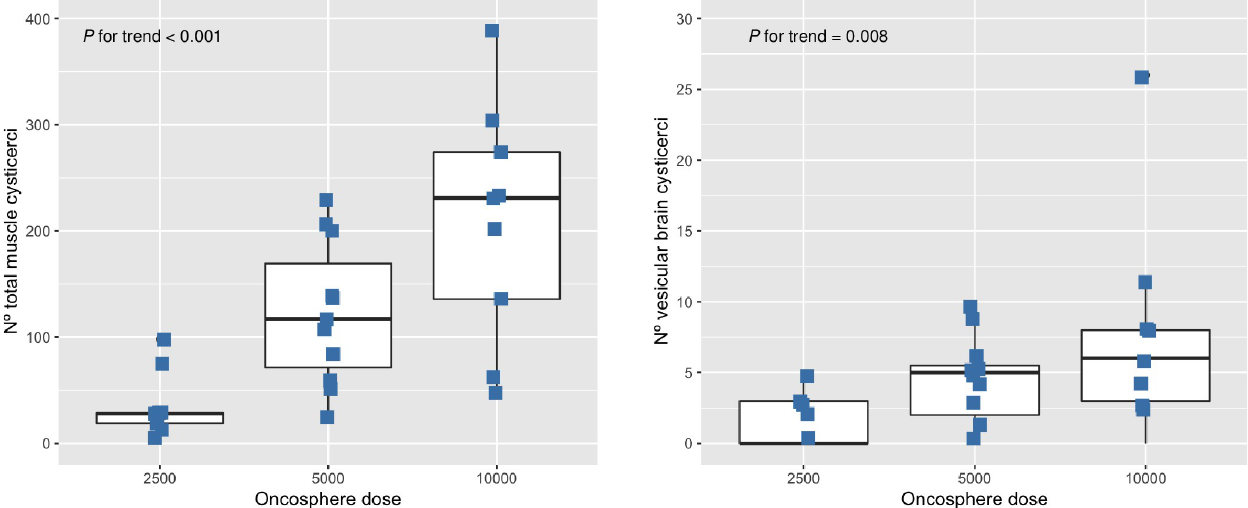
Fig 2. Boxplots showing the distribution of total muscle cysticerci (A) and vesicular CNS cysticerci according to dose groups. P value was obtained by using nonparametric Cuzick’s trend test. The median is represented as the horizontal line in the box, and the lines (whiskers) outside the wall are extended to cover all data points that lie within 1.5 ± IQR (interquartile ranges) from upper and lower quartiles respectively. Data points outside whiskers represent outliers.